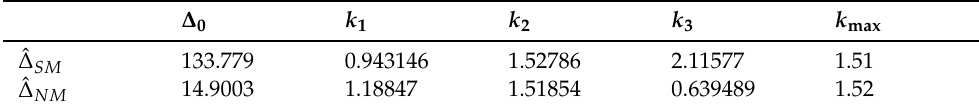
Table 2. Parameters of the reference gaps from [37]. The unit of length is femtometer and the unit of energy is megaelectronvolt. With kind permission of The European Physical Journal